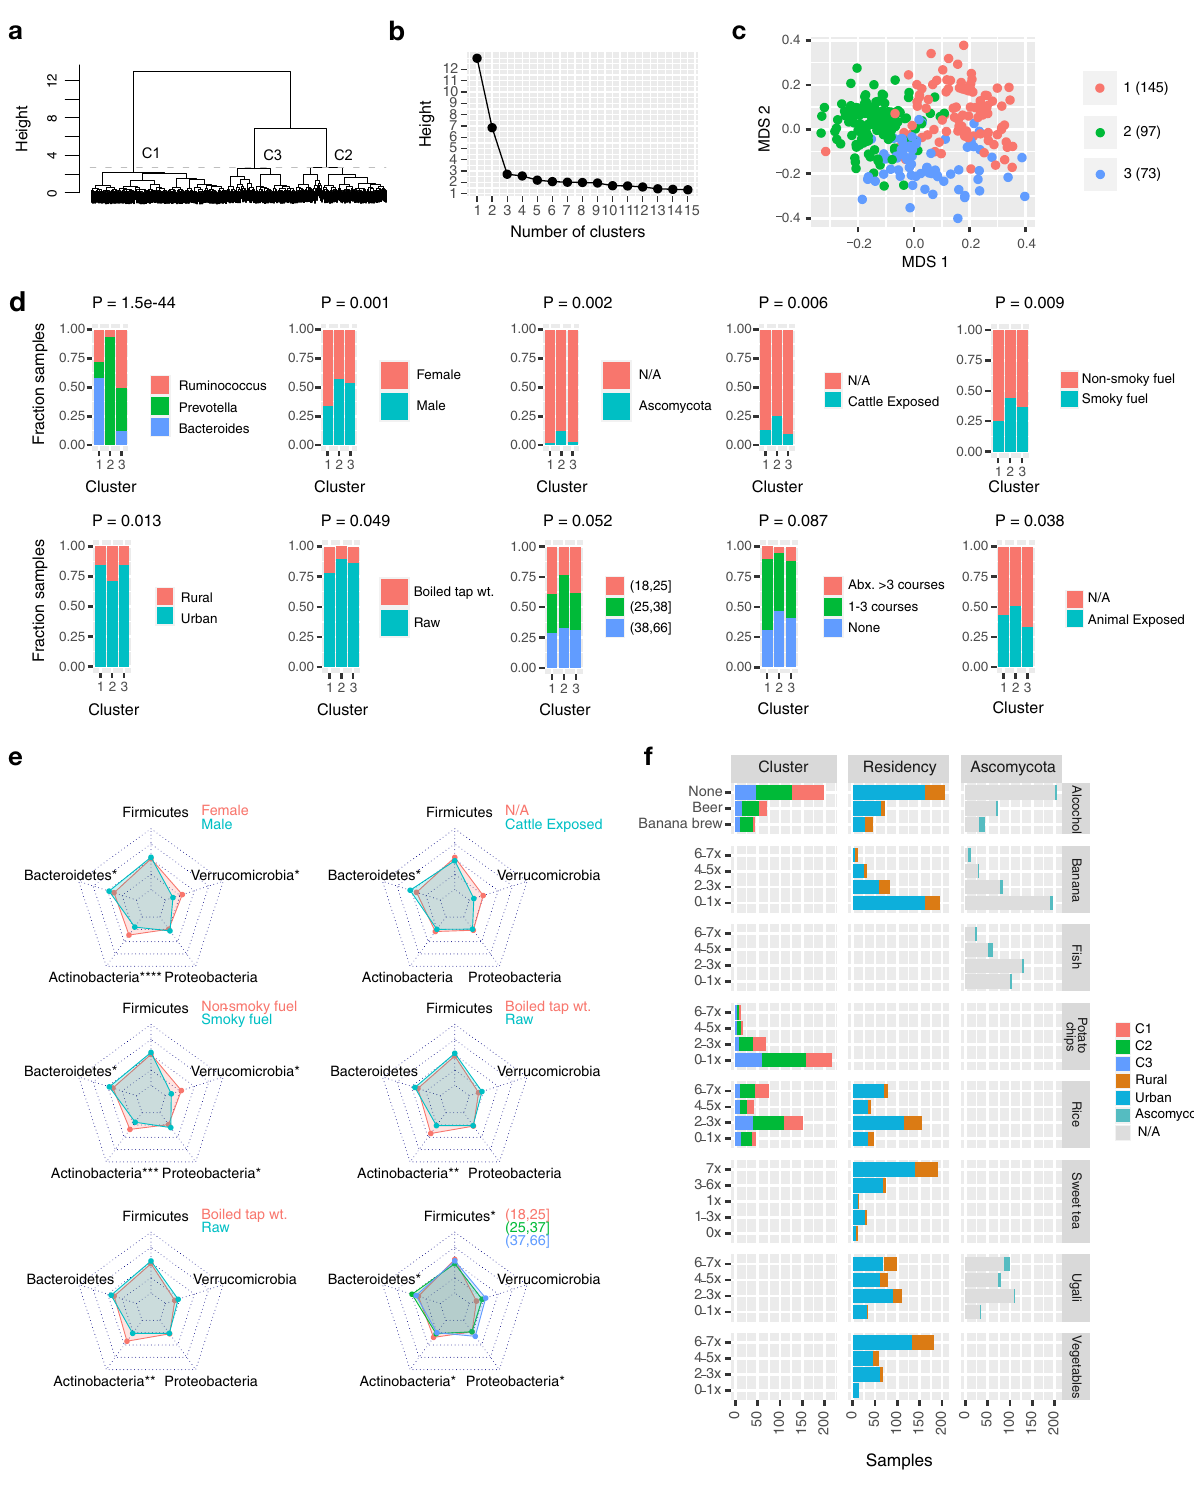
Fig. 2 Environmental factors drive the Tanzanian microbial compositions. a Dendrogram of samples based on Jensen-Shannon distances between species relative abundances. b Three clusters are determined based on dendrogram height. c Multidimensional scaling (MDS) of cohort. d Cluster dependence on anthropometric variables (Chi-square test with unadjusted P -values <0.05), of which eight most associated are shown: enterotype, age interval, gender, Ascomycota presence, cattle exposure, fuel type, residency, and drinking water quality. e Changes in phyla abundance with selected variables using Maaslin2 (two-tailed t-test, P FDR < 0.25). Radar plots span the 5 and 95% percentiles of relative abundances for each phylum (* P ≤ 0.05, ** P ≤ 0.01, *** P ≤ 0.001, **** P ≤ 0.0001 for exact P -values). f Dietary factors signi fi cantly associated with microbiome clusters, residency, and presence of fungi ( P < 0.05, Chi-square test or Kruskal – Wallis test, “ Methods ” ). Ranges on the y -axis indicate weekly frequency or type of consumed food or drink. Source data are provided in the Source data fi